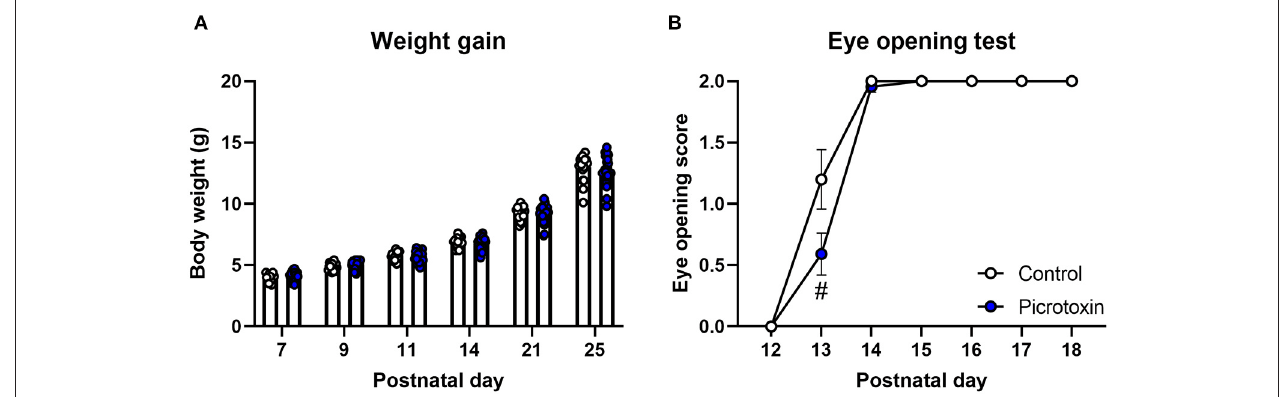
FIGURE 1 | Body maturation and eye-opening scores. (A) No significant difference in body weight was found between control and picrotoxin-exposed male mice. (B) A trend toward a difference in eye opening was observed between control and picrotoxin-exposed male mice on P13. The data are expressed as mean ± SEM. # p <